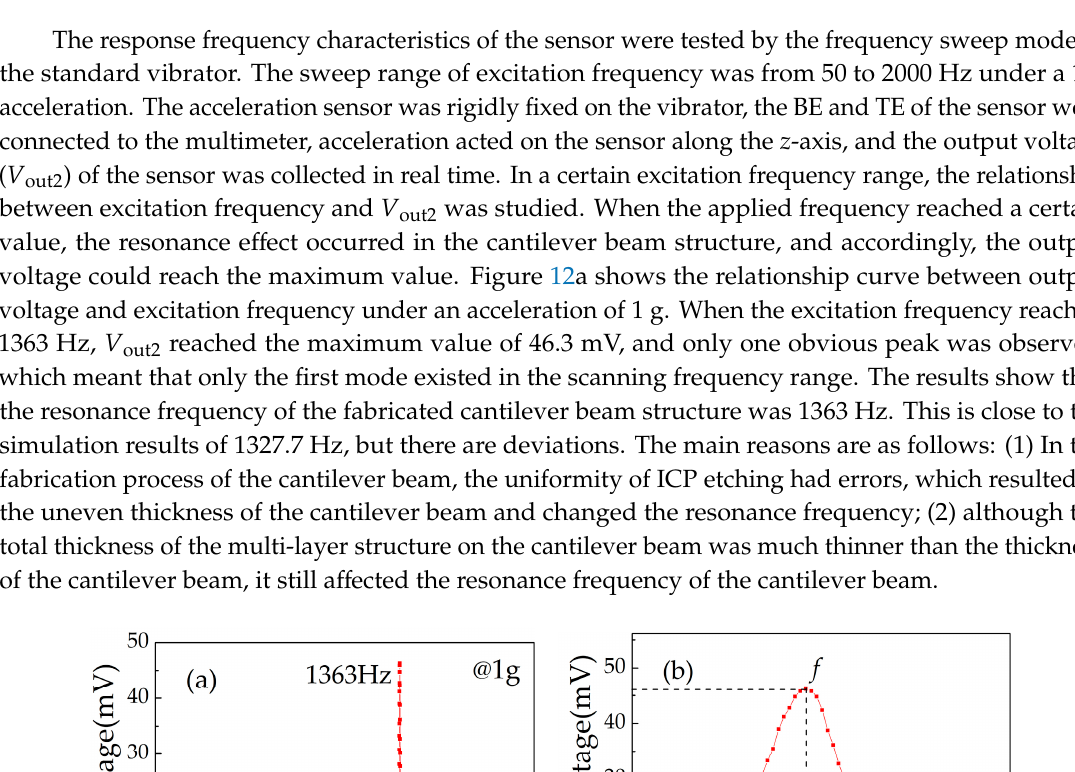
Figure 11. Testing system of acceleration sensor.